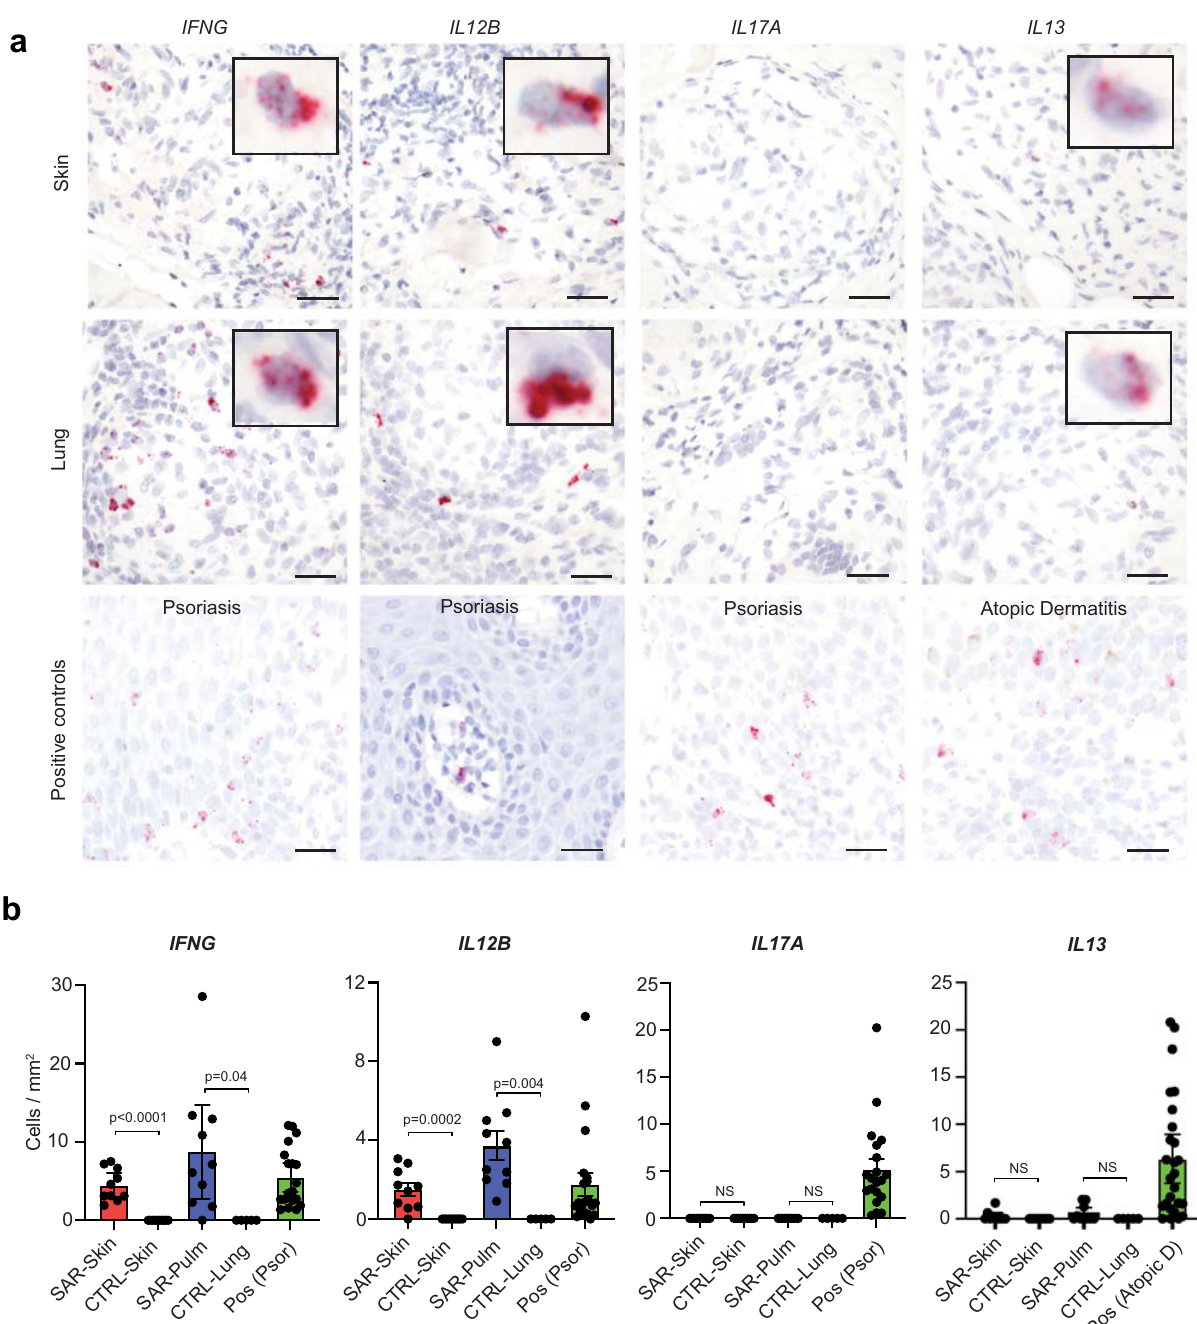
Fig. 7 Type 1 immunity is the predominant immune polarization in sarcoidosis. a Photomicrographs showing representative RNA in situ hybridization staining patterns for selected markers (red chromogen) with hematoxylin counterstain (blue), scale bar: 50 μ M, higher power inset. b Histograms showing quanti fi cation of RNA in situ hybridization staining for selected markers in control skin ( n = 10), control lung ( n = 5), cutaneous sarcoidosis ( n = 10) and pulmonary sarcoidosis ( n = 10) tissue. Data are presented as mean + / − 95% con fi dence interval, p values calculated using unpaired t tests, NS: not signi fi cant, Pos: positive control, Psor: psoriasis biopsies ( n = 20), Atopic D: Atopic dermatitis biopsies ( n = 26). Source data are provided as a Data Source